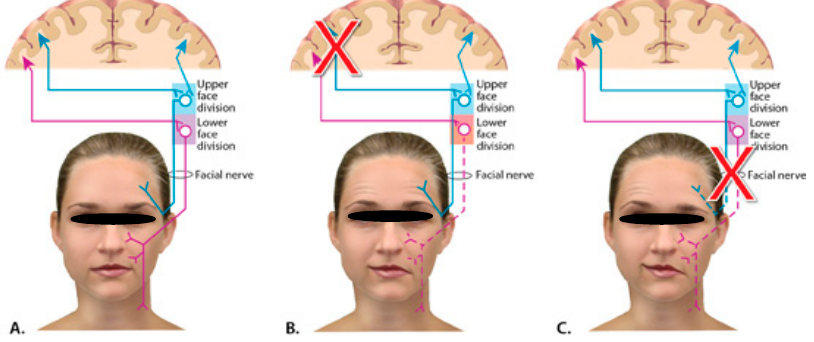
Figure 1. Illustrative nerve pathways from the face to the brain. ( A ). Normal condition. ( B ). Problem is affecting the lower face division. ( C ). Full side affected.